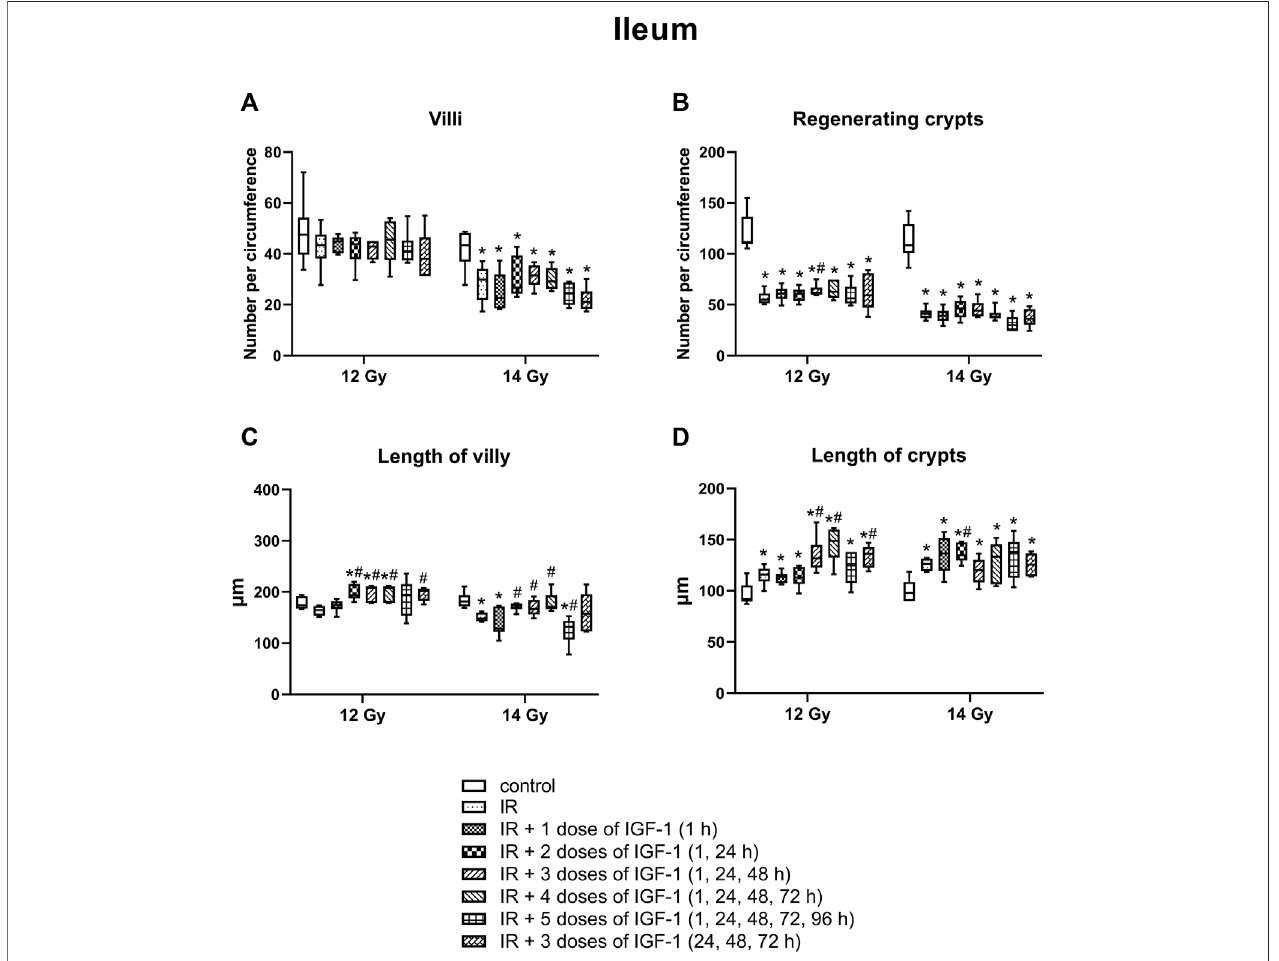
FIGURE7| Effectofdifferenttherapeutical regimensofIGF-1(1 mg/kg)onileumofmiceirradiatedby12or14 Gywithshieldedheadandneck. (A) numberofvilly. (B) numberofsurvivingcrypts(microcolonyassay). (C) lengthofvilly. (D) lengthofcrypts.Signi fi cantlydifferentwhencomparedwiththenon-irradiatedcontrol:* p ≤ 0.05. Signi fi cantly different when compared with the solely irradiated group receiving no treatment: # p ≤ 0.05.